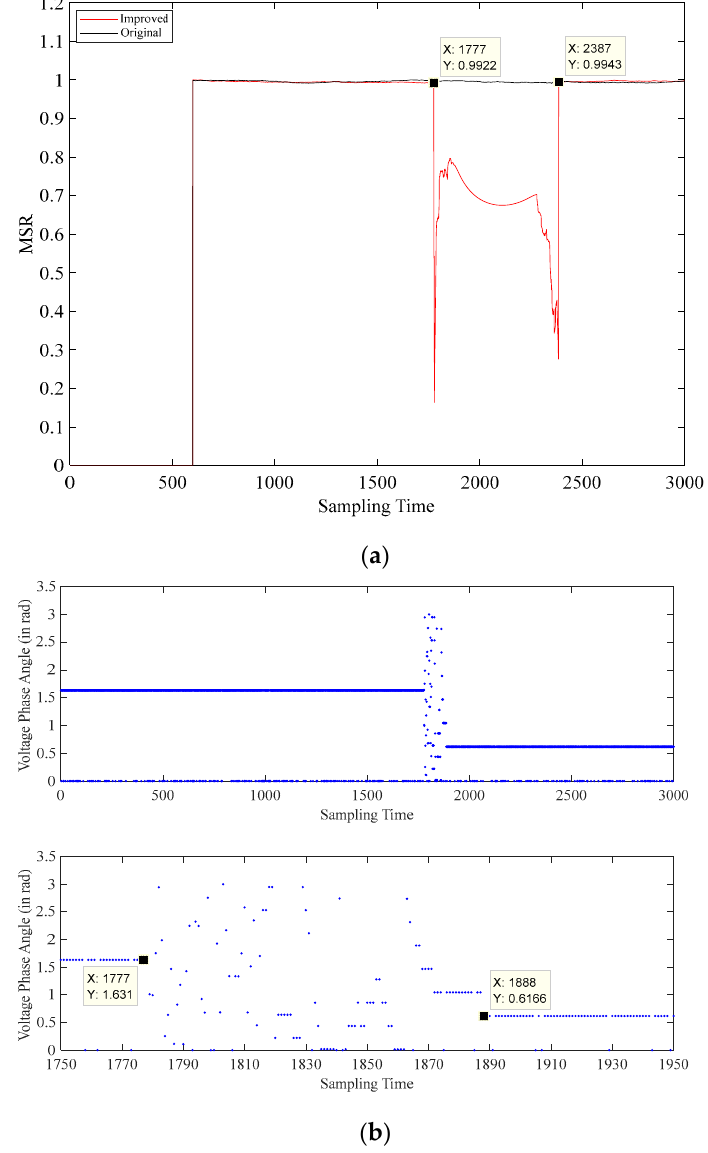
Figure 5. ( a ) MSR-t curves of the improved and original event detectors, ( b ) voltage phase angle of a certain PMU, event detection using voltage phase angles of real PMU data.